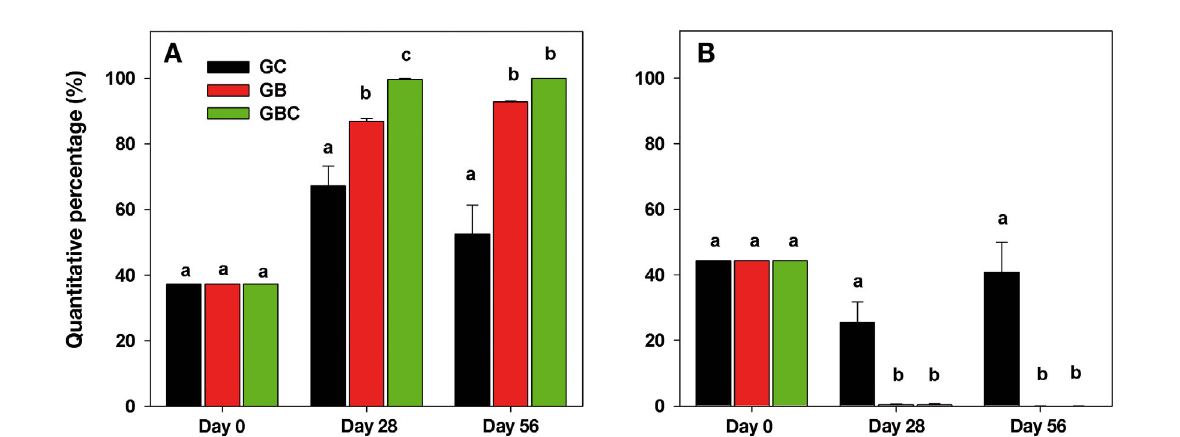
Fig. 2. Percentages (mean ± SD) of (A) Chlorophyta and (B) Cyanophyta among microalgae in different treatment groups (see Table 1) on Days 0, 28, and 56. Different lowercase letters indicate significant difference among groups at the same sampling time (ANOVA, p < 0.05) (Fig. 3B). The number of heterotrophic bacteria in